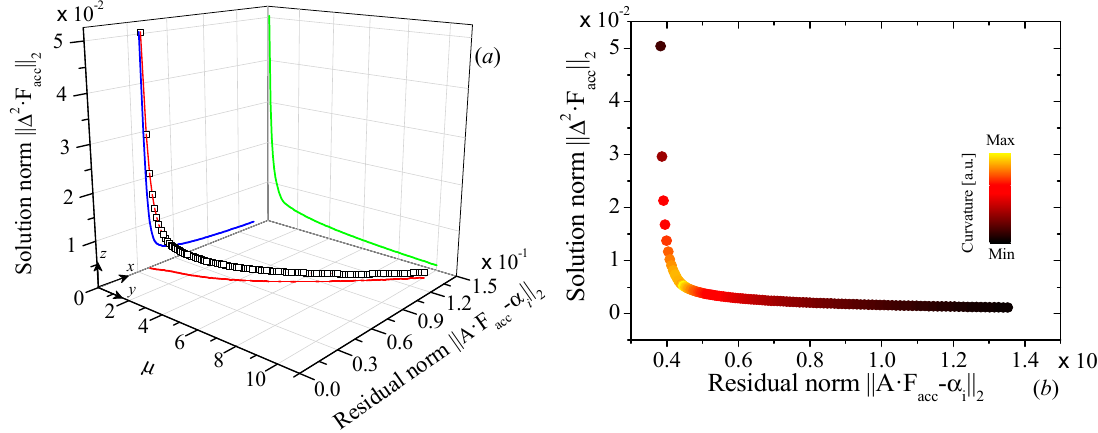
Figure 2. ( a ) Three-dimensional visualization of the relation between the L-Curve (blue) and the different values of μ for a cross-plane Fuchs-Sondheimer suppression function at T = 300 K for graphite simulations. ( b ) L-curve or xz projection of 3D curve, the maximum curvature is displayed as heat-like color bar.